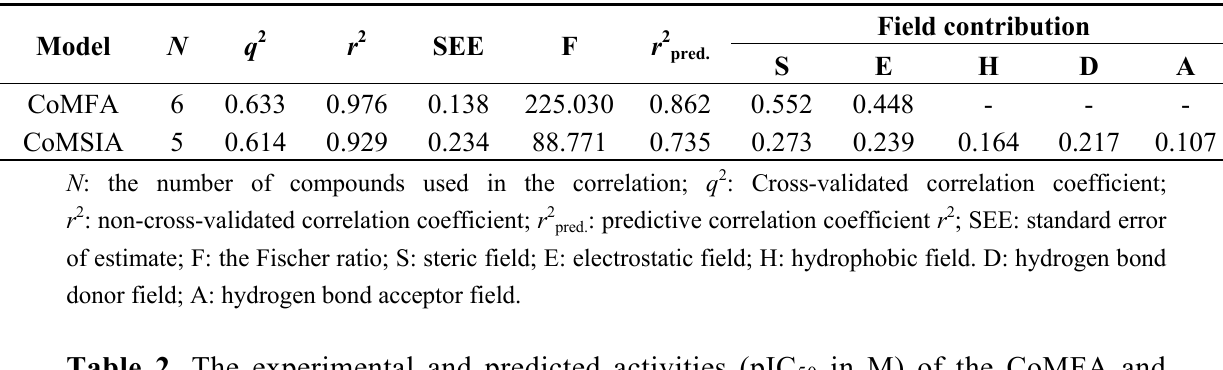
in M) of the CoMFA and 50